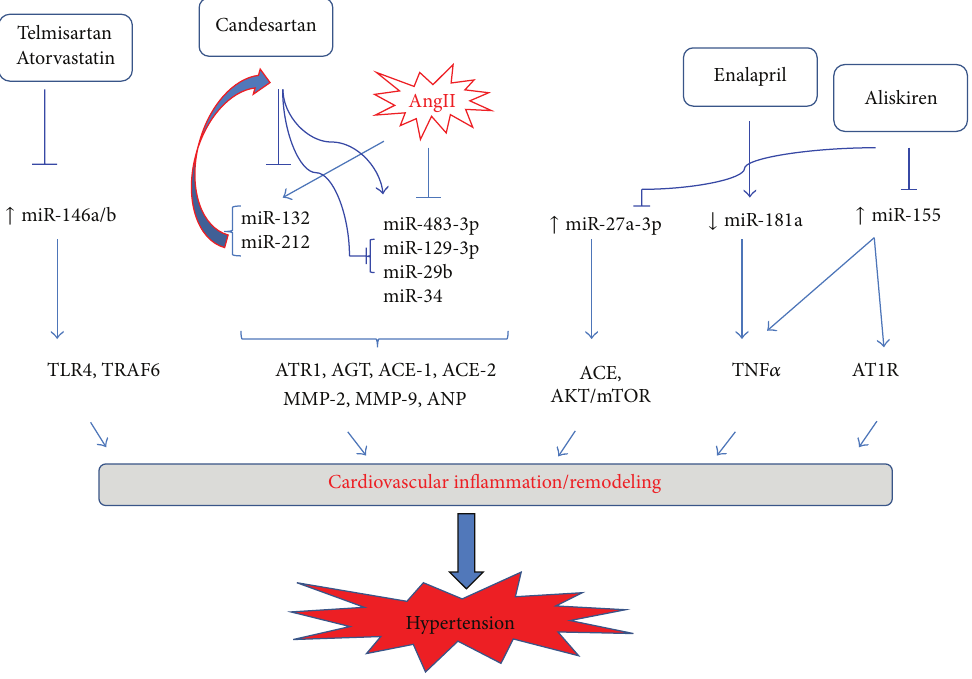
Figure 1: Dependent and independent RAAS-regulated microRNAs signaling in cardiovascular inflammation/remodeling and hypertension. Ang II regulates its level via stimulating miR-132, miR-212, and its downstream signaling via suppressing miR-483-3p, miR-129-3p, miR-29b, and miR-34 by increasing the expression of AT1R, AT2R, ACE1, ACE2, Col1A, and TGFbeta. Several microRNAs regulate RAAS signaling independent of Ang II via regulating inflammation and remodeling miR-146a/b, miR-181a, miR-155, miR-129-3p, and miR-29b. RAAS inhibitors differentially regulate microRNAs: telmisartan, atorvastatin, aliskiren, and candesartan inhibit miR-146a/b, miR-132, miR-212, miR-155, miR-129-3b, and miR-29b. Enalapril stimulates the expression of miR-181a which targets TNF 𝛼 therefore regulating inflammation and remodeling. ↑ : increased level, ↓ : decreased level; ⊥ : inhibition, and → : stimulation. AT1R: angiotensin II type 1 R; ACE: angiotensin converting enzymes; AGT: angiotensinogen; TLR4: toll-like receptor 4; TRAF6: TNF receptor associated factor